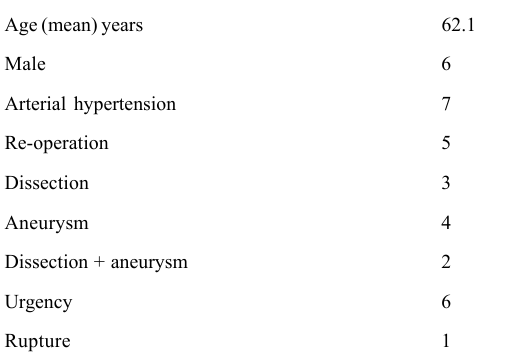
Table 1. Right Carotid Perfusion - Patients’ Clinical Characteristics